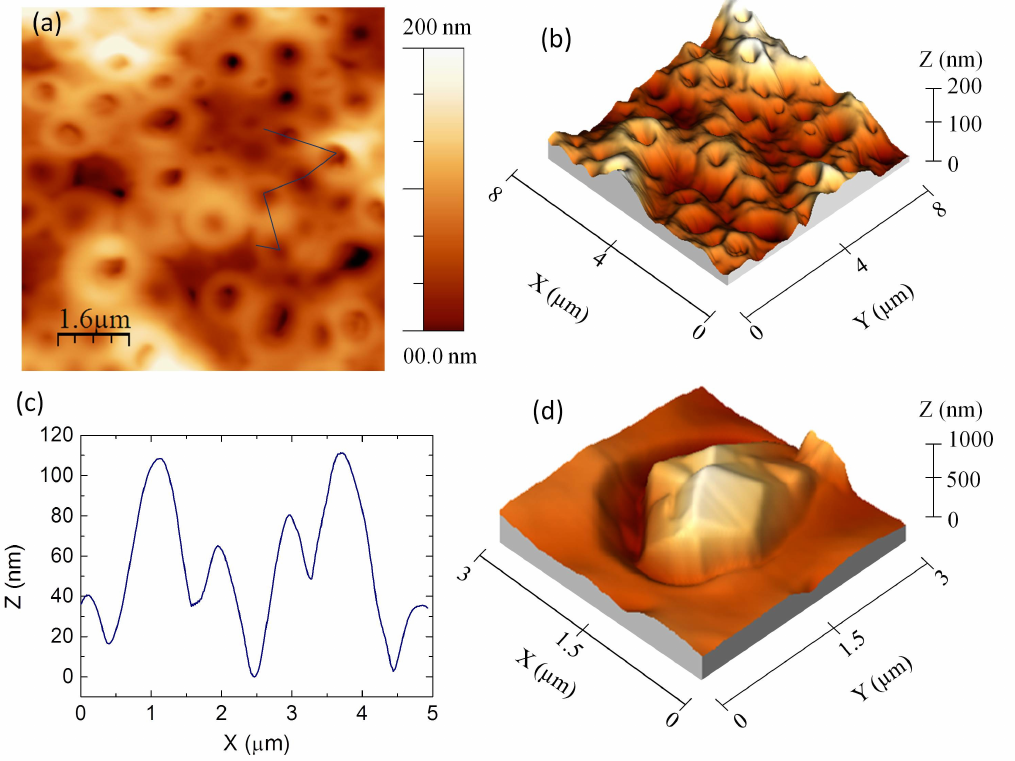
Figure 7: AFM images of MMMs surface with a filler content of 20% wt. In Figure 7 (a), the corresponding height scale is included as colour